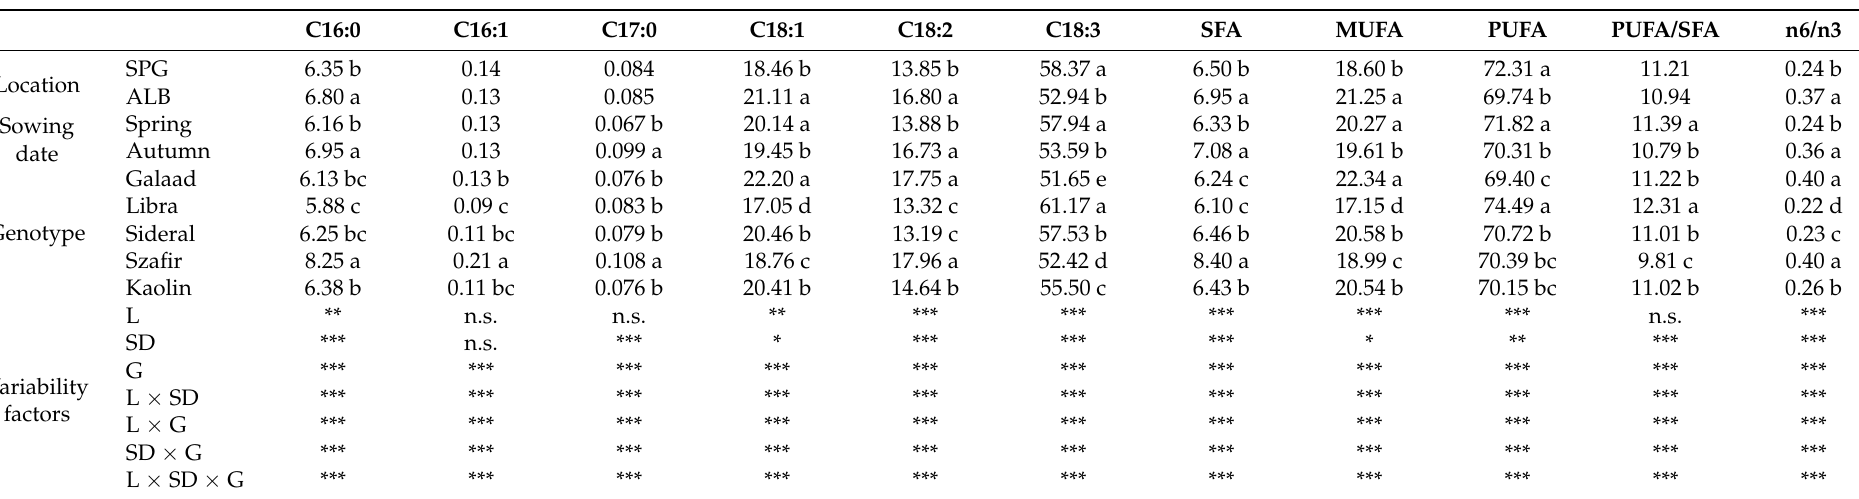
Table 8. Fatty acids composition (% of total FA) in linseed in response to location (L), sowing date (SD) and genotype (G). Data refer to mean